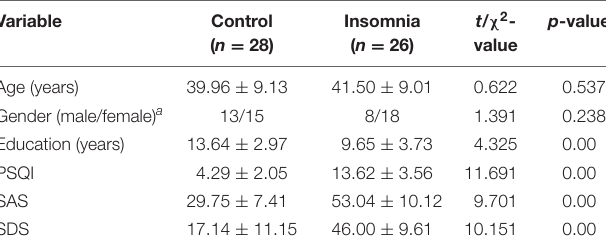
TABLE 1 | Demographic information of the participants in current study.